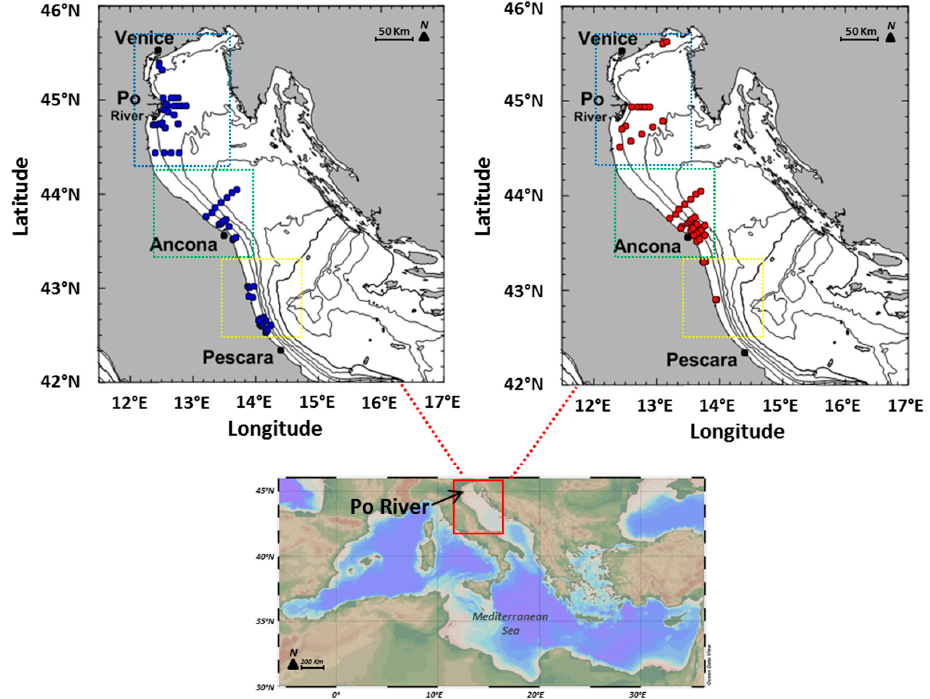
Figure 1. Study area. In the upper pictures, the blue dotted box indicates Zone A, the green dotted box Zone B and the yellow dotted box Zone C (see text). In the top left picture, stations pertaining to the test data set are indicated by blue dots, in the top right picture the red dots indicate stations pertaining to the validation data set. Many stations were sampled more than once. In the lower picture, the red box indicates the location of the study area in the Mediterranean basin.